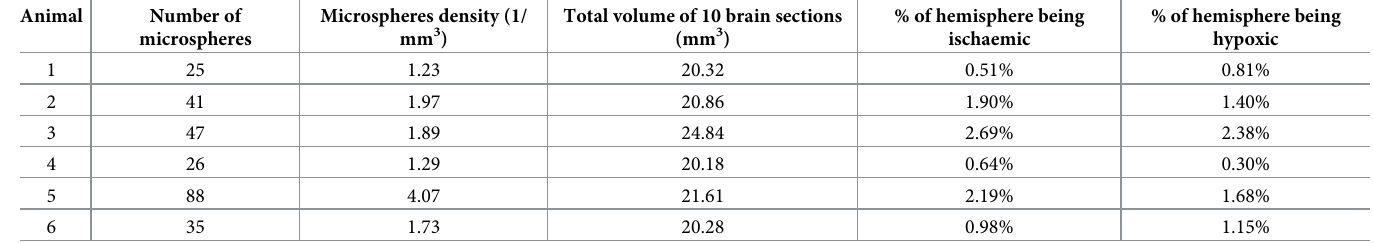
Table 2. Number and density of microspheres, total brain volume and % of ischaemia and hypoxia per animal. These numbers were measured in the reconstructed brain volumes with a thickness of 500 μ m. Animal Number of microspheres